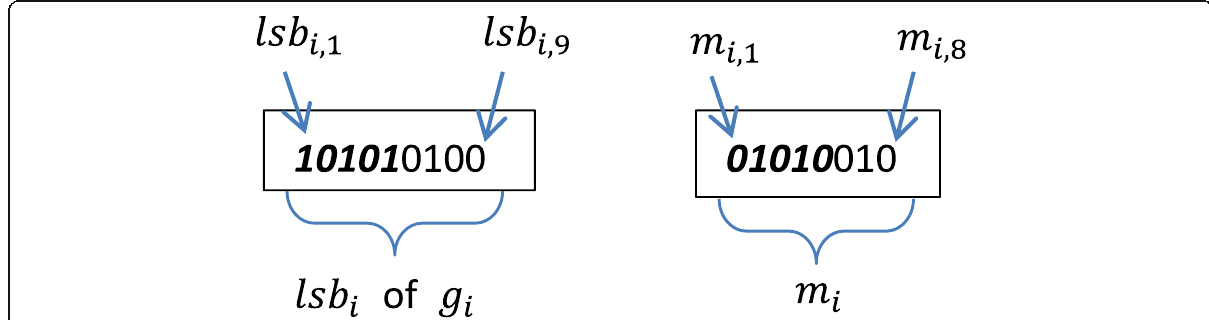
Fig. 5 Illustration for d i > l/2. The length l is 8 and d i is 5. So embedding bits is 10101101 and lsb i,9 will be set to 1